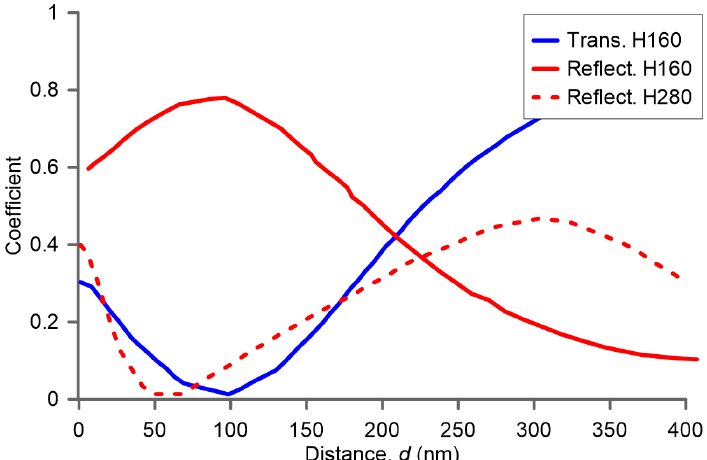
Figure 4. Reflected (red) and transmitted power (blue) for a metasurface of Si nanoparticles with h = 160 nm, r = 74 nm (solid line) and h = 280 nm, r = 60 nm (dashed line), as a function of distance between nanoparticles (NPs). Only transmission with h = 160 nm is shown.